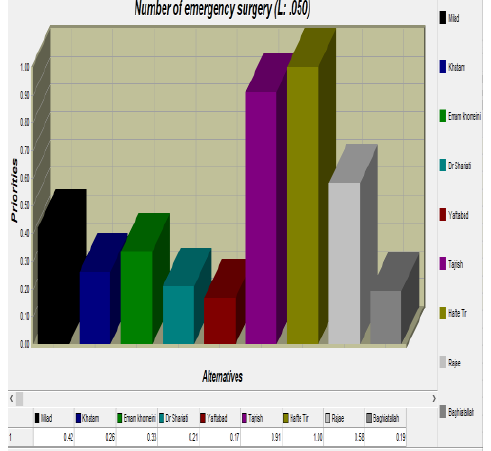
Figure 8. Ranking hospitals in terms of index E. Figure 9. Ranking hospitals in terms of index F.